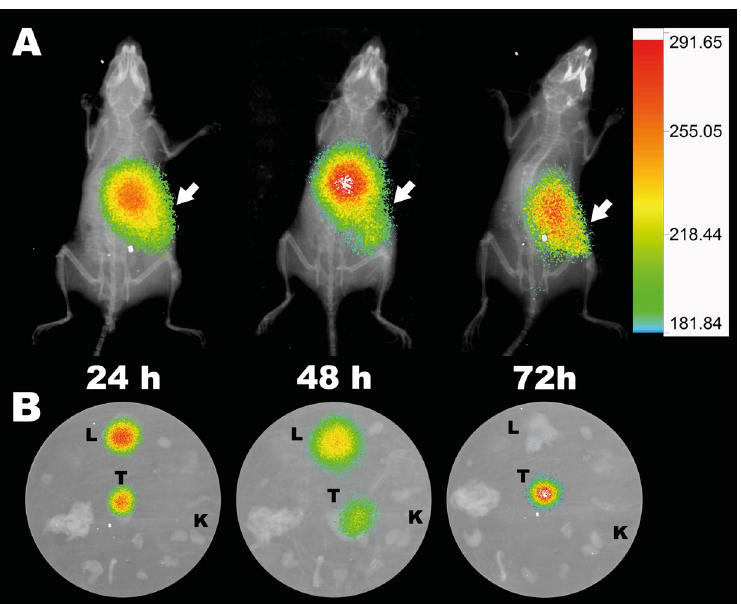
Figure 9. Multimodal images of animals injected with Sgc8-c-NOTA- 67 Ga probe. ( A ) In vivo and ( B ) Ex vivo images at 24, 48 and 72 h post-injection of the probe. Arrow indicates the locations of the tumors. T: tumor, L: liver and K: kidneys. Ex vivo images also include bone, lungs, blood, heart, muscle, intestine, stomach, thyroid, and